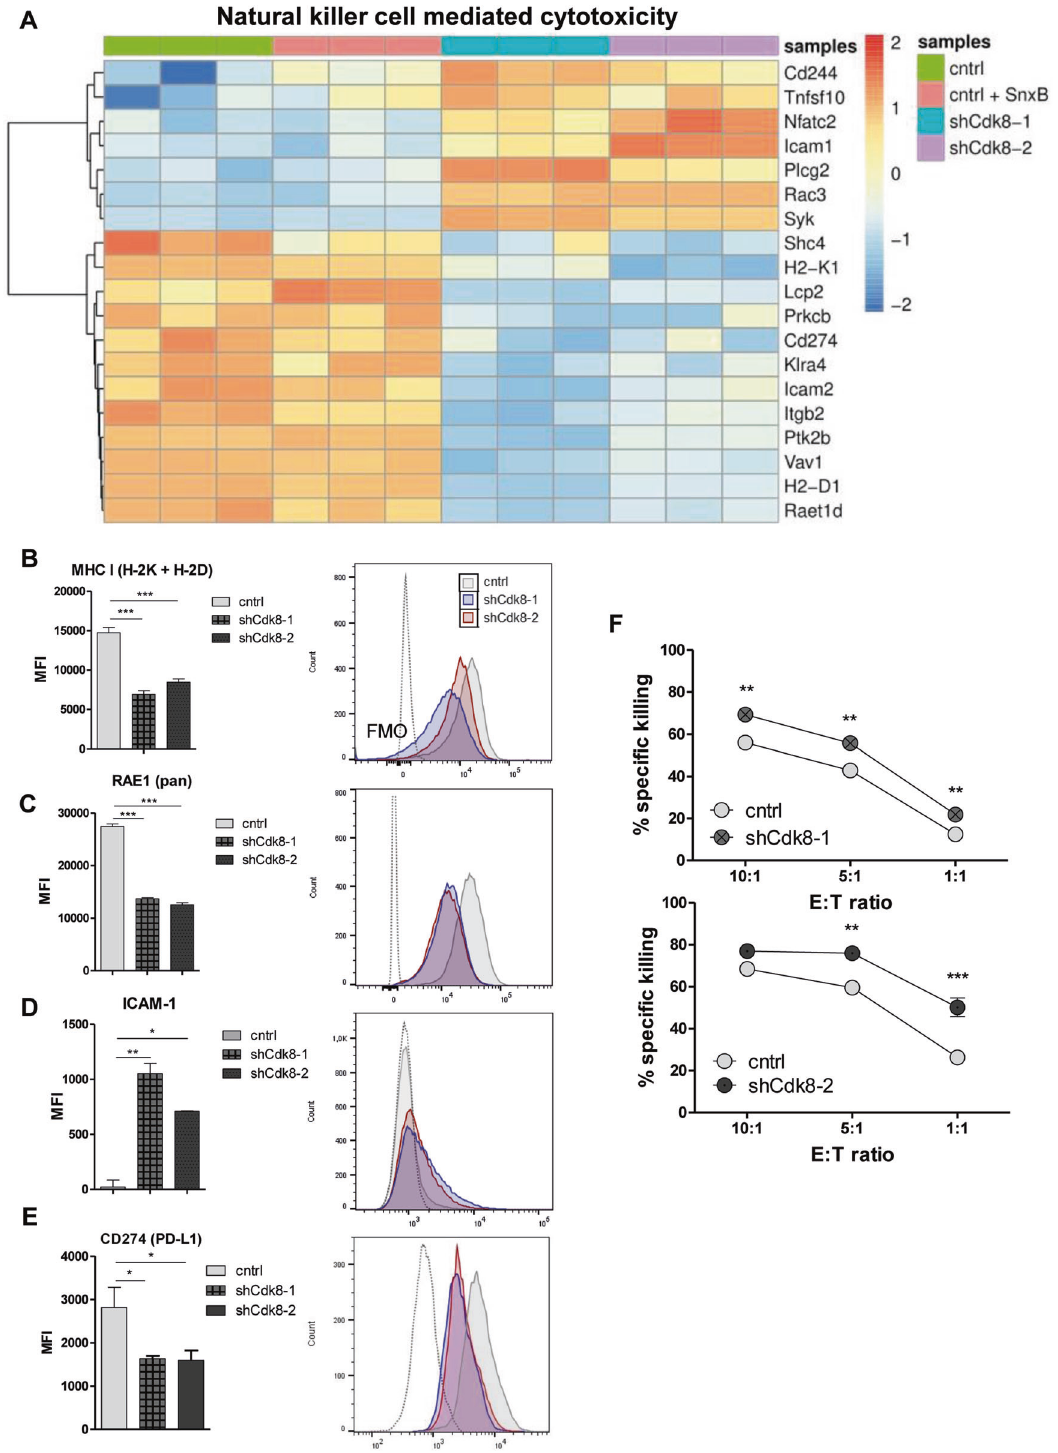
Fig. 3 Loss of CDK8 enhances TNBC ’ s visibility to NK cells. A Heatmap of differentially expressed genes between untreated or Senexin B-treated E0771 control cells and shCdk8-1 or shCdk8-2 cell lines in the KEGG pathway “ Natural killer cell-mediated cytotoxicity ” (RNA sequencing data; n = 3 replicates). B – E Median fl uorescence intensity (MFI) and representative histograms of ( B ) MHC I (H-2K + H-2D), ( C ) RAE1 (pan), ( D ) ICAM-1, and ( E ) CD274 (PD-L1) expression of E0771 control, shCdk8-1, and shCdk8-2 cells; expression levels of NK ligands were analyzed by fl ow cytometry. Bar graphs represent technical triplicates (mean ± SEM). F IL-2-expanded C57BL/6 NK cells were incubated for 4 h with CFSE-labeled E0771 control or shCdk8-1/shCdk8-2 tumor cells in effector:target (E:T) ratio of 10:1, 5:1, and 1:1. The speci fi c killing was assessed by fl ow cytometry. One representative experiment out of two to three independent experiments is shown. Symbols and error bars represent mean ± SEM of technical duplicates.